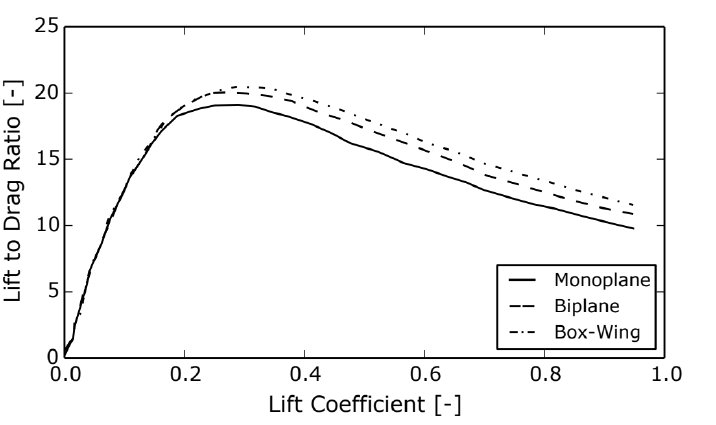
Figure 1. Aerodynamic efficiency comparison taken from Andrews [15]. Both the biplane and box wing have a height-to-span ratio of 0.2. Adapted from Gall and Smith